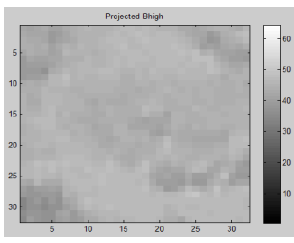
Figure 9b. Projected 32 × 32 pixels for green channel